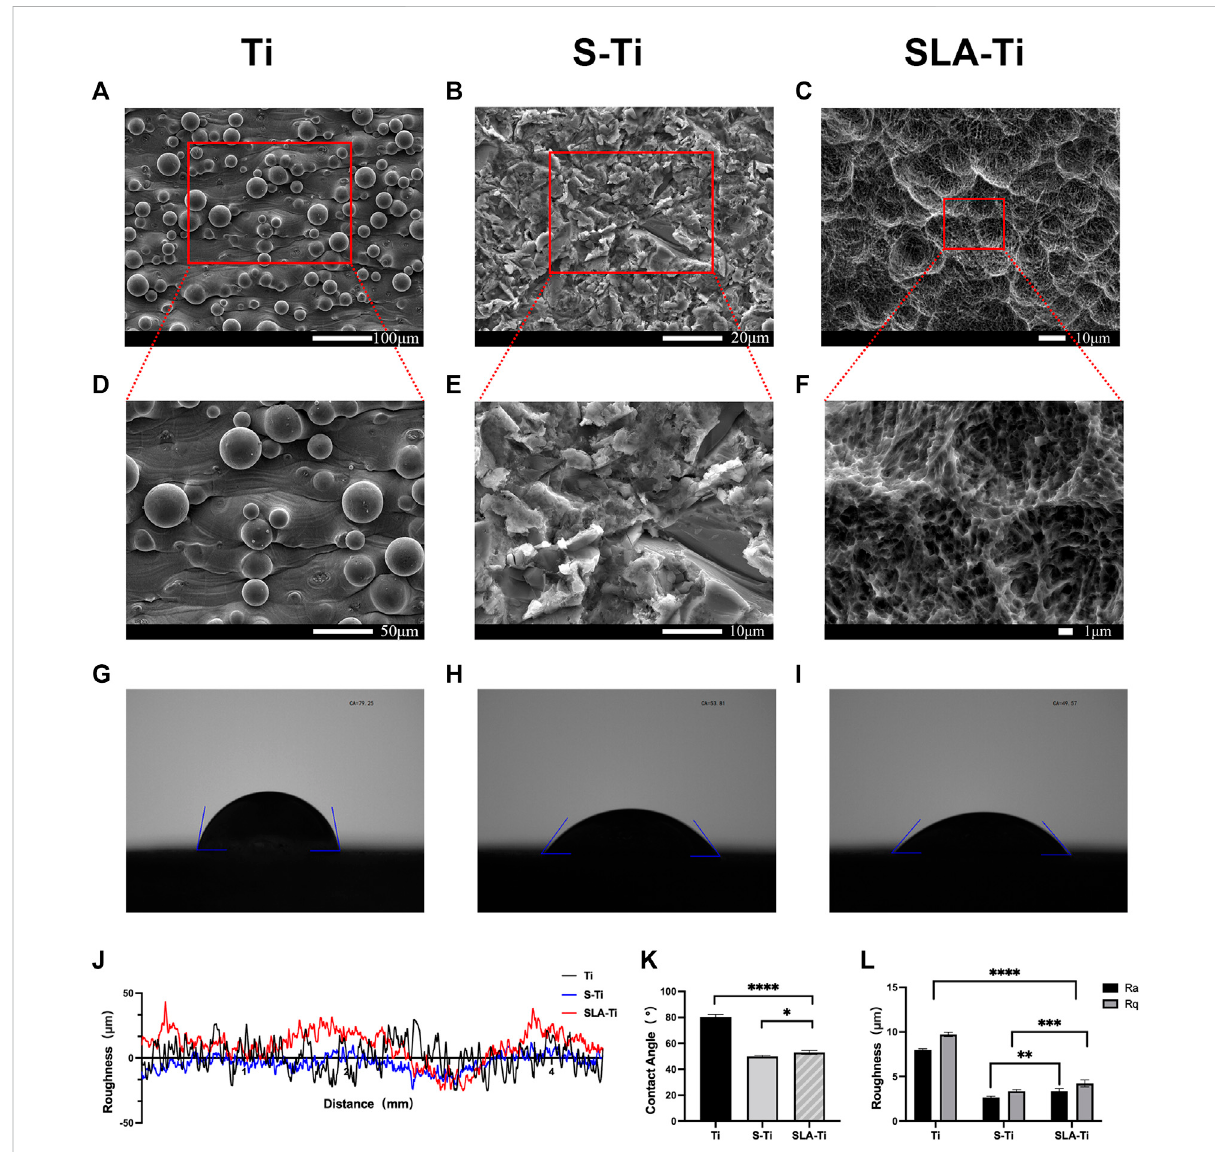
FIGURE 6 SEMimagesofTi (A,D) ,S-Ti (B,E) ,andSLA-Ti (C,F) ;watercontactanglesofTi (G) ,S-Ti (H) ,andSLA-Ti (I) ; (J,L) SurfaceroughnessofTi,S-Tiand SLA-Ti; (K) contact angles of Ti, S-Ti and SLA-Ti. Error bars represent means ± SD and specimens number n = 5.